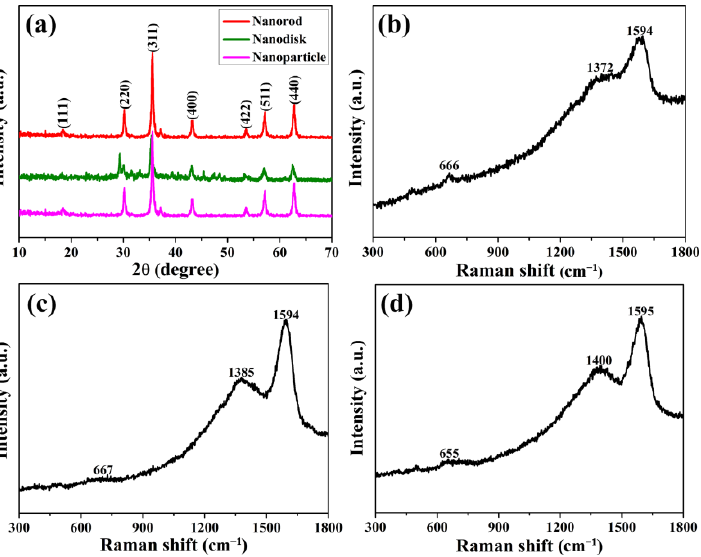
Figure 3. ( a ) XRD patterns of the three C@Fe 3 O 4 composites; Raman spectra of the C@Fe 3 O 4 composites ( b ) nanorod, ( c ) nanodisk, and ( d ) nanoparticle.